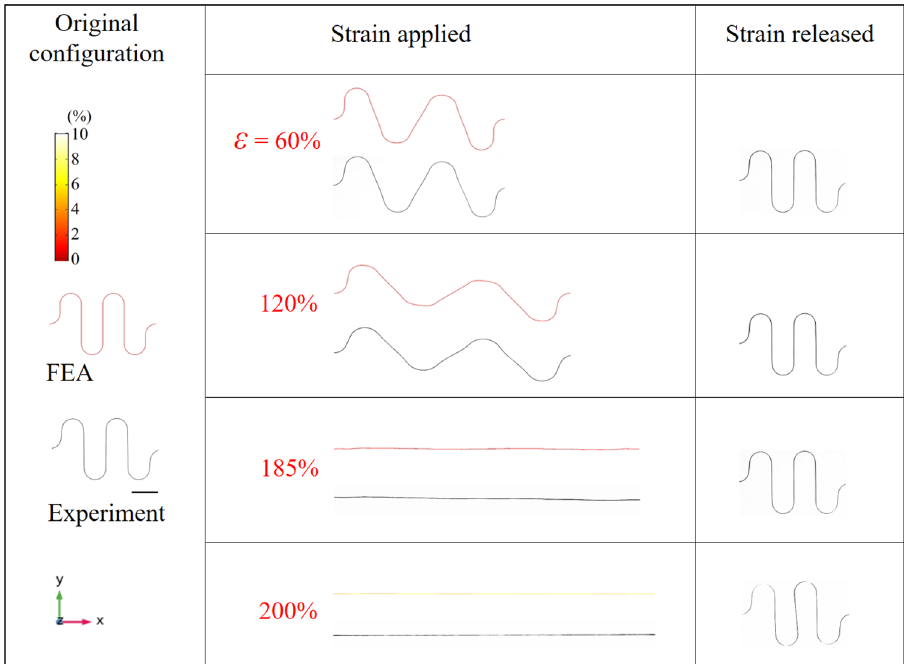
Fig. 4 Stretchable experiments and simulations. The middle column shows optical images (gray image) and their corresponding FEA simulation results (color image) for the interconnect under different applied tensile strain. The right column shows the interconnect structures after releasing the applied strain. The scale bar is 2 mm.